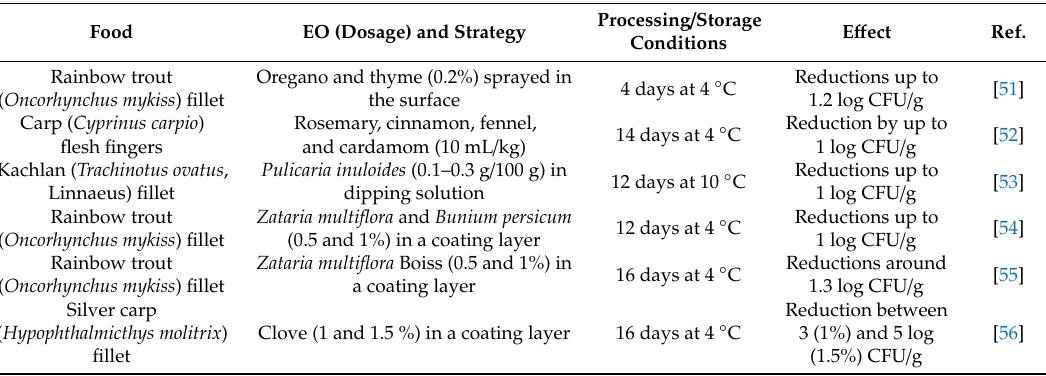
Table 3. Influence of essential oils on E. coli strains in